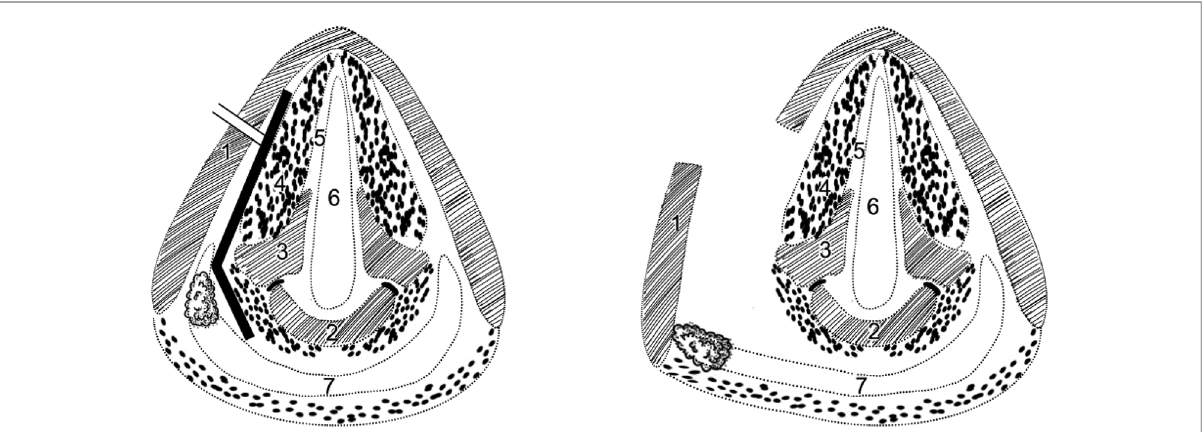
FIGURE 1 Schematic diagram of paraglottic space approach horizontal section of larynx at the level of the glotti 1=thyroid cartilage, 2=cricoid cartilage, 3=arytenoid cartilage, 4=thyroarytenoid muscle, 5=vocal cord, 6=airway lumen, 7=lumen of the hypopharynx black solid line=paraglottic space, double slash=incision of thyroid